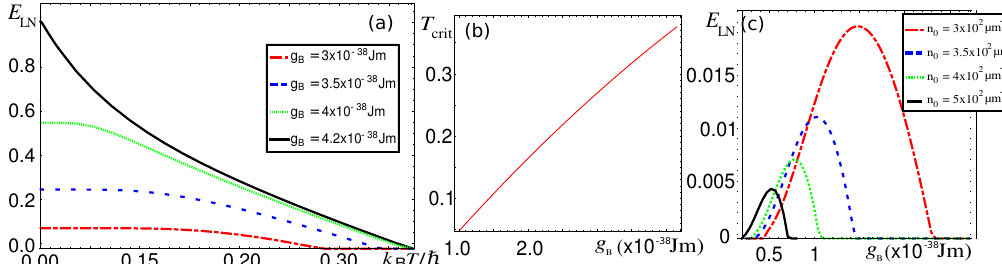
Figure 6: Dependence of the entanglement between the two kinds of impurities on the coupling constant between the bosons g . In (a) we study entanglement as a function B of T for various g . As can be seen for the largest considered value of g , namely B B = 4.2 · 10 − 38 J · m , the qualitative behaviour of entanglement with temperature, g B changes. For each density, at certain T , the entanglement vanishes. The depen- crit dence of T as a function of density is shown in (b). In (c) we illustrate that the crit entanglement at fixed T increases for a range of g and then decreases to zero, as it B was the case with η in Fig. 1. We show this dependence for various values of the 2 density of the bosons. As shown, in this range of parameters, decreasing n increases 0 the maximum value of the entanglement reached, but also entanglement vanishes at larger values of g . In all of the graphs, we are considering impurities of potassium B K in a bath of particles of Rubidium Rb. The parameters used in these plots are: Ω = 600 π Hz , Ω = 450 π Hz , η = 0.325, η = 0.295, n = 90 ( µ m ) − 1 , T = 4.35 nK 1 2 1 2 0 / a = and R 12 HO